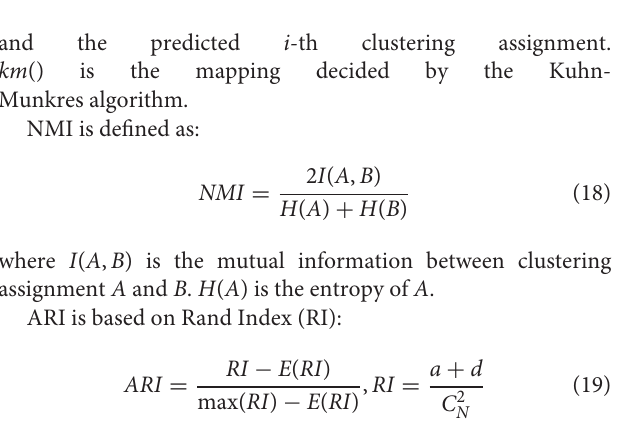
shows the t-distributed Stochastic Neighbor Embedding (t-SNE) figures of DDNMF and AE1 on two datasets. The visualization also exhibits the good performance of